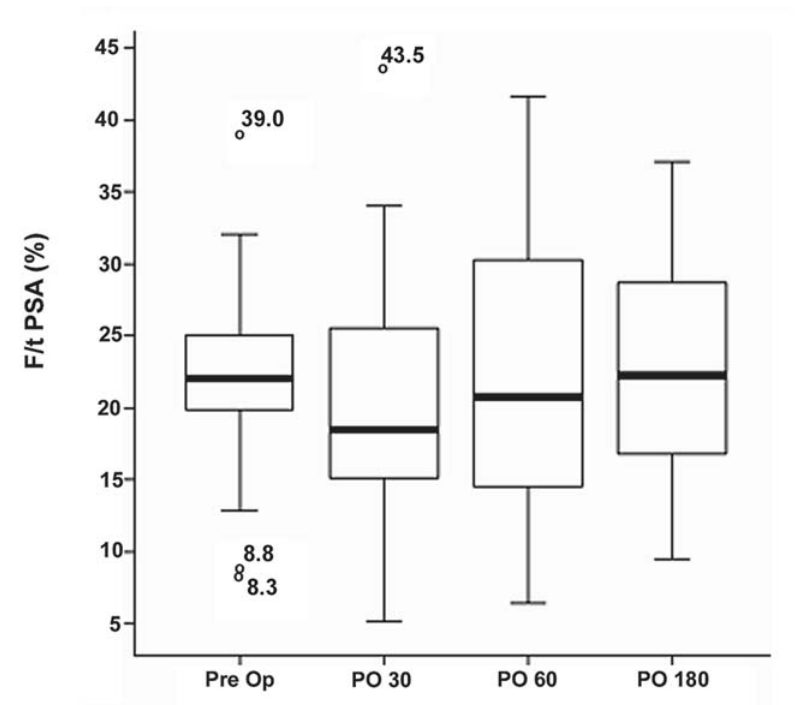
Figure 3 – F/t PSA at baseline and postoperative days 30, 60 and 180.